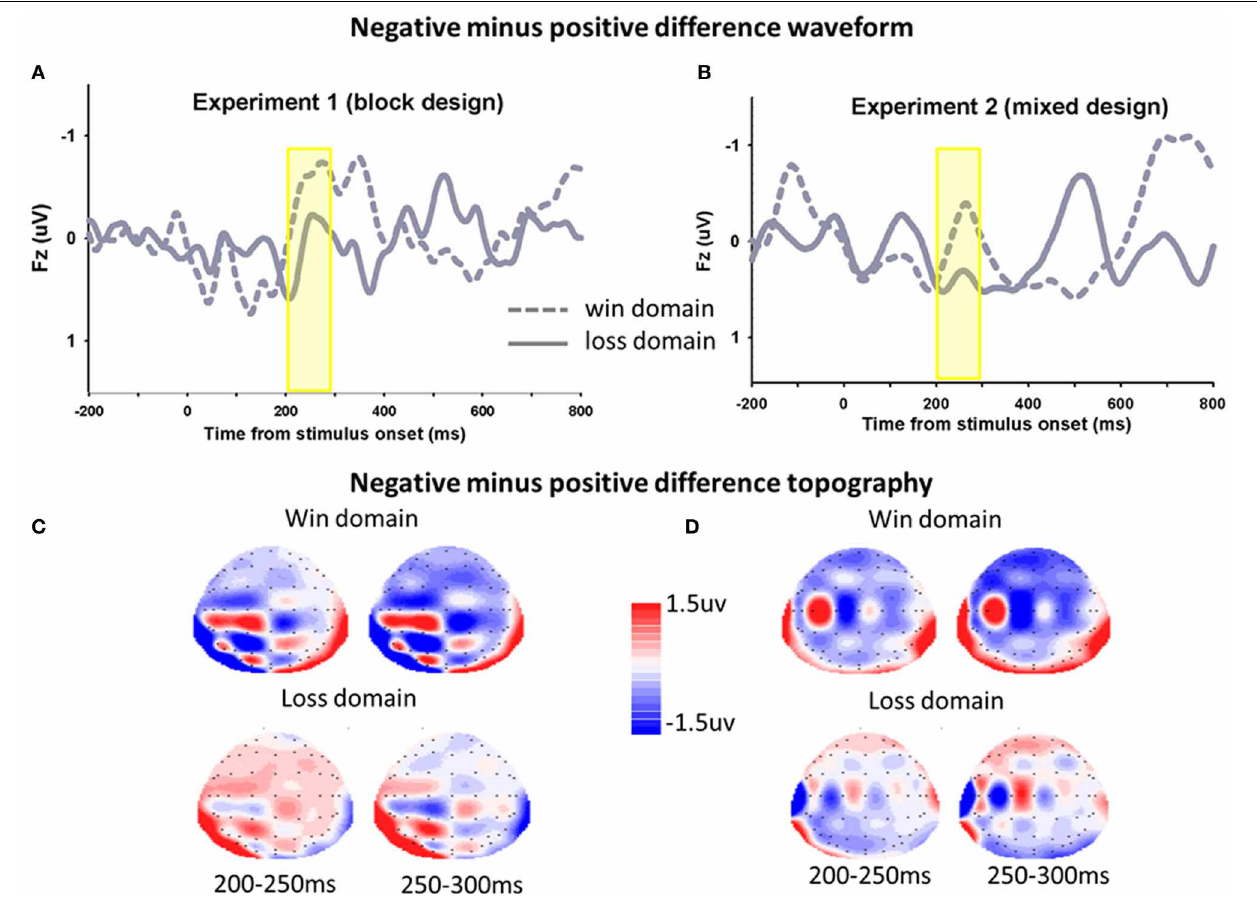
FIGURE 4 | The ERP difference waveforms and topograph (FRN). In Experiment 1 (A) and Experiment 2 (B) , difference waveforms (negative minus positive) in the win domain and the loss domain were shown. The corresponding topographical maps (200–300, 50ms increment) were shown (C,D)